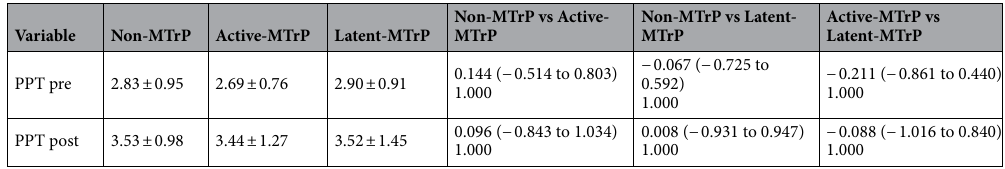
Table 3. PPT over trapezius muscle. Comparison between groups. Comparison between groups: Difference of means, Confidence interval and P value according to Bonferroni’s correction. *Indicates statistical significance P < 0.05.